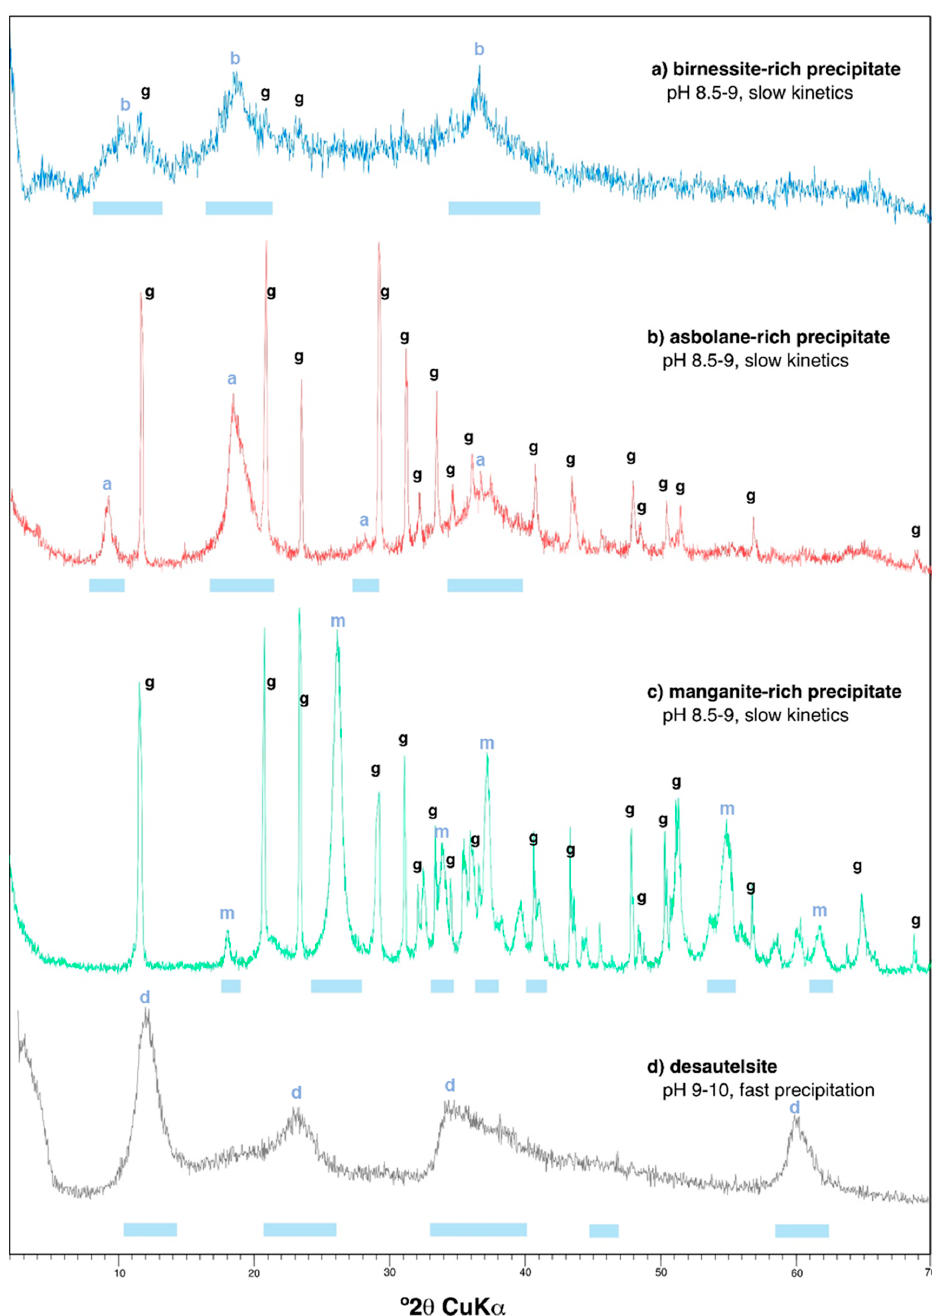
Figure 2. X-Ray diffraction (XRD) patterns obtained for precipitates formed during the Mn(II) oxidation experiments at pH 8.5–9.0 under slow precipitation kinetics: ( a ) brinessite-rich precipitate, ( b ) asbolane-rich precipitate, and ( c ) manganite-rich precipitate. The diffractogram of desautelsite ( d ), obtained by fast precipitation kinetics during neutralization at pH 9–10 in a previous study ([38]) was included for comparison. The blue bars at the bottom of each XRD pattern indicate the positions of diagnostic reflections for the dominant Mn oxide phase in each precipitate (b, birnessite; a, asbolane; m, manganite; d, desautelsite). The label “g” denotes peaks of gypsum, which were also accidentally formed in some solutions during the experiments.